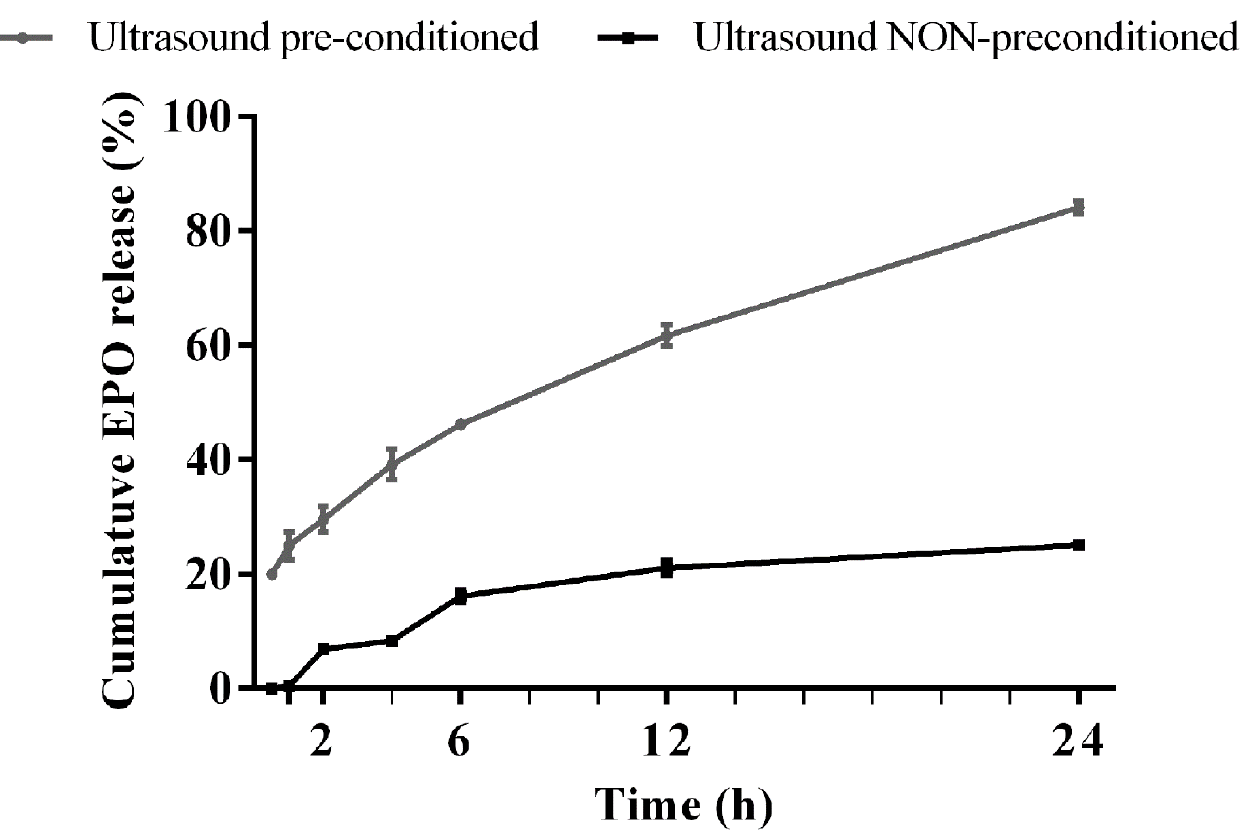
Figure 1. Cumulative release ratios of erythropoietin from the erythropoietin nanobots. The data are shown as the mean ± SD (error bars).